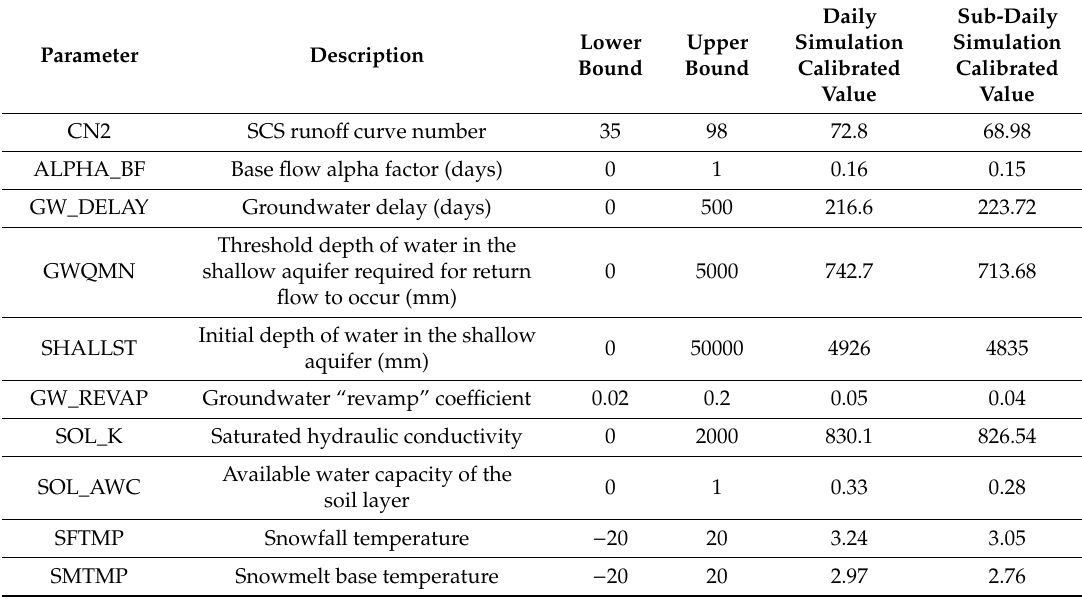
Table 1. Important parameters in the model calibration